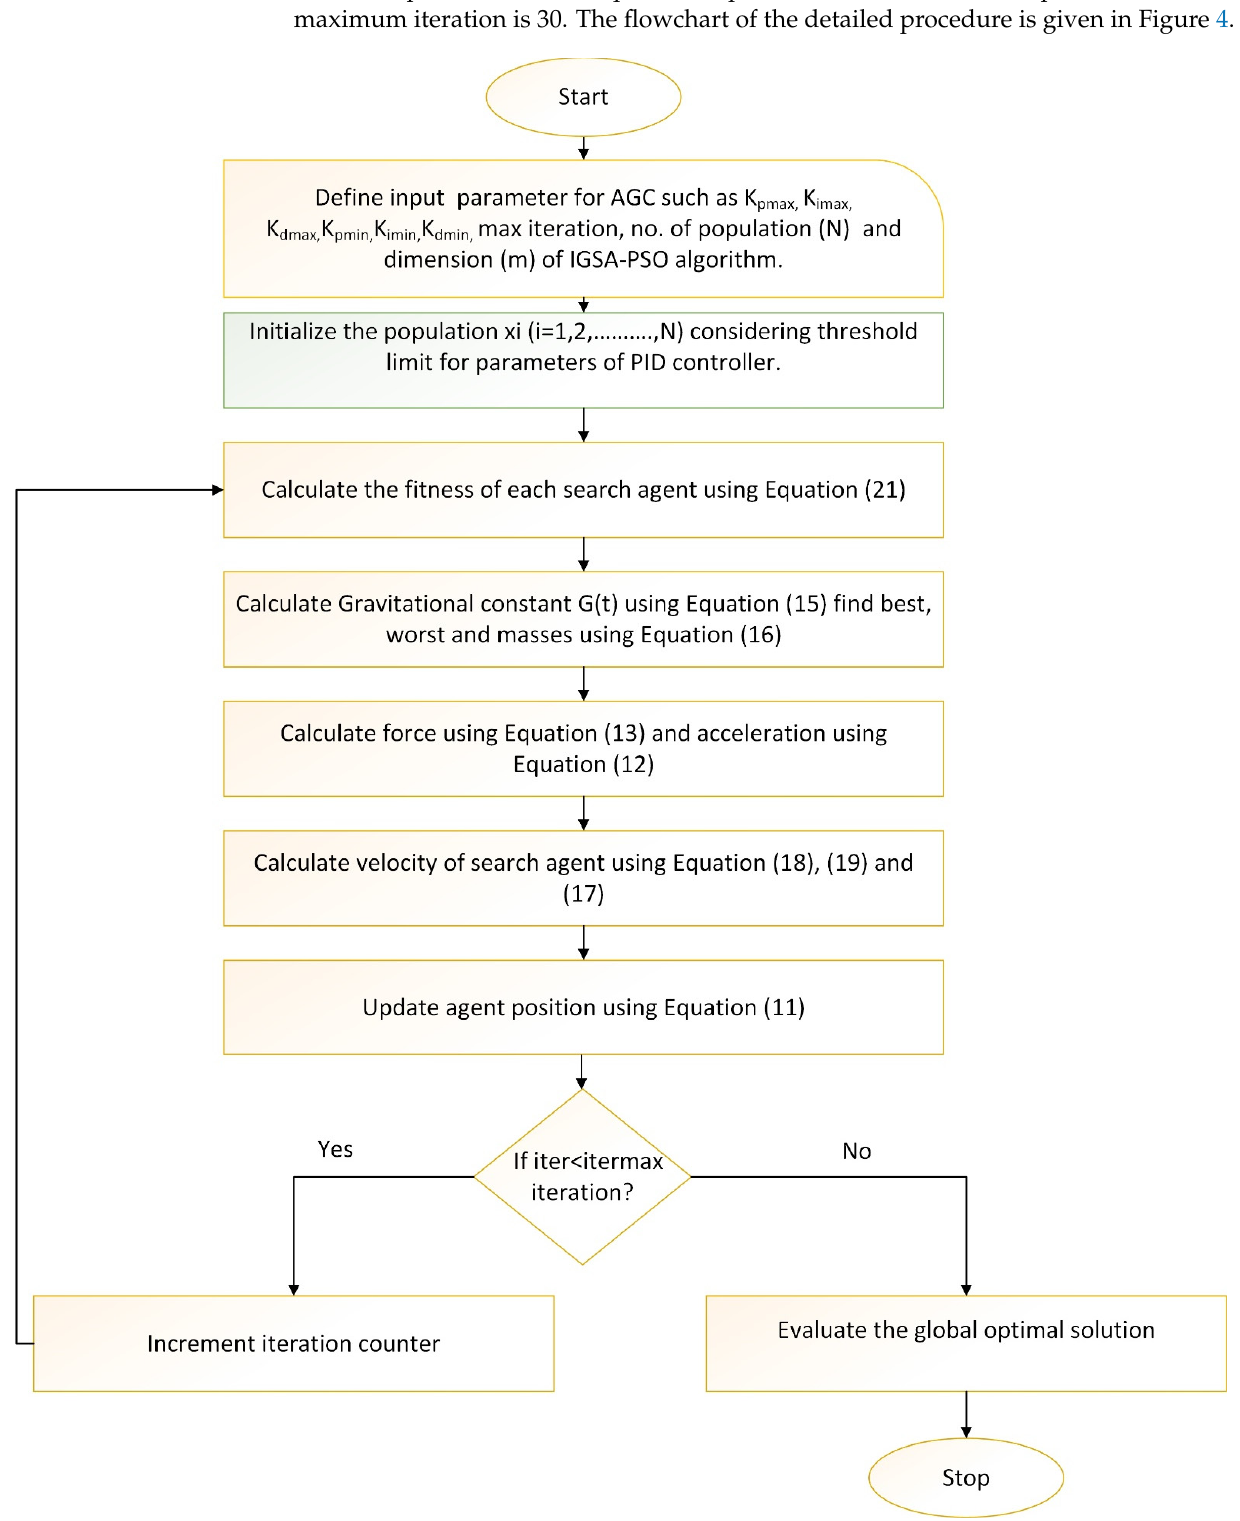
Figure 4. IGSA-BPSO flowchart of the detailed procedure.